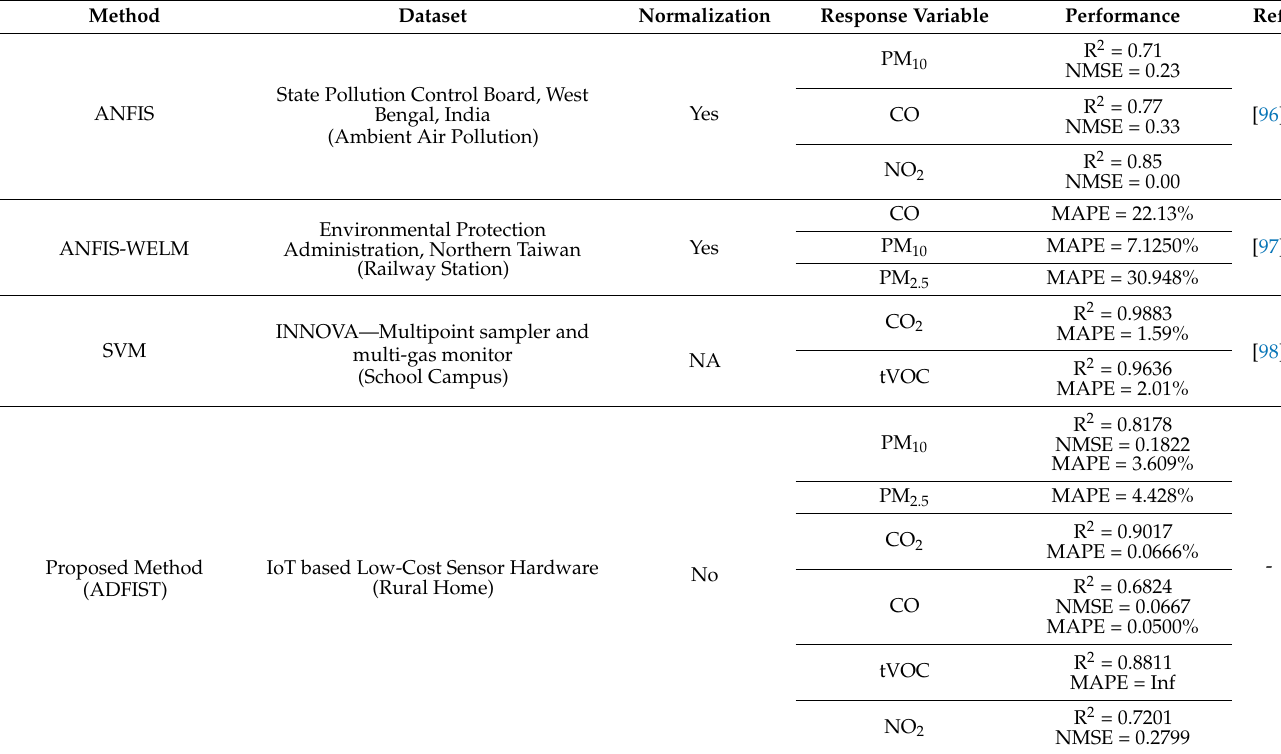
Table 7. Comparison of proposed Optimized DFIST model with existing studies in the